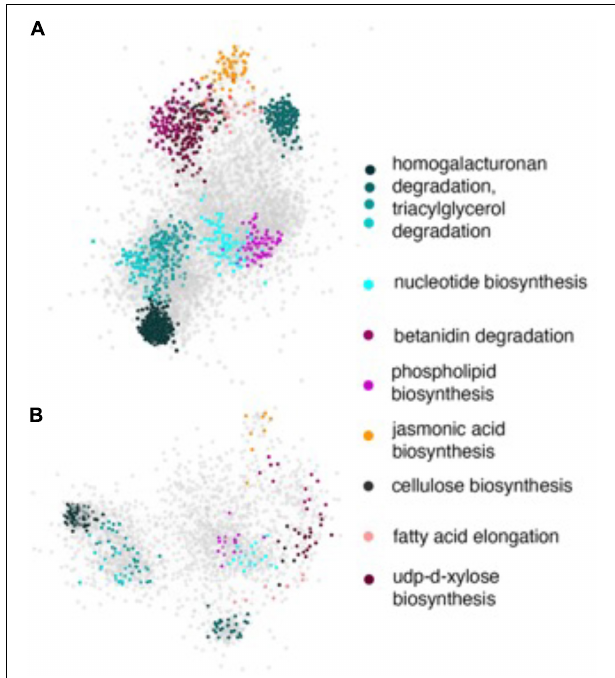
FIGURE 8 | Subnetworks of PL and NSP. All statistically significant SNPs were mapped to the genic regions of the rice reference genome and the resulting genes were used as input to query the rice regulatory network. (A) The subnetwork induced by the PL gene-list and (B) the subnetwork induced by NSP gene list. In both the panels, genes are represented by ellipses and are color coded according to the module they are a part of. Gray ellipses represent genes that are part of modules with no functional annotations yet. The functional annotations of colored modules are shown in the key on the right. Note that some of these modules were not significantly enriched within the query